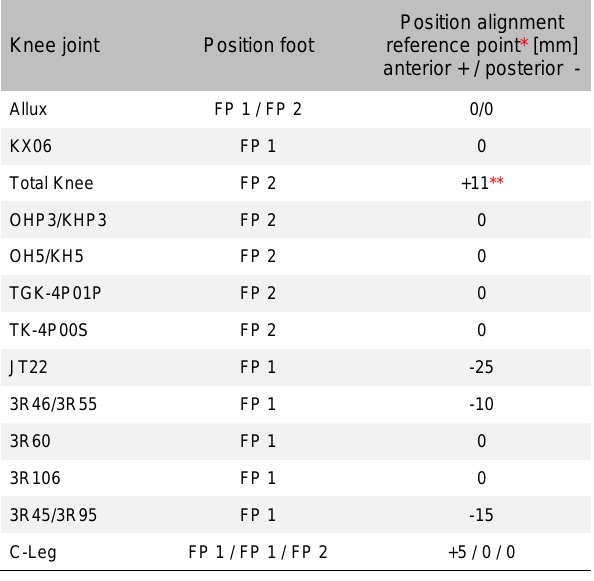
*Upper anterior axis for polycentric knee joints, knee rotation axis for monocentric knee joints **Offset between reference axis defined by the manufacturer (aligned on the alignment reference line) and upper anterior axis is approximately 11 mm